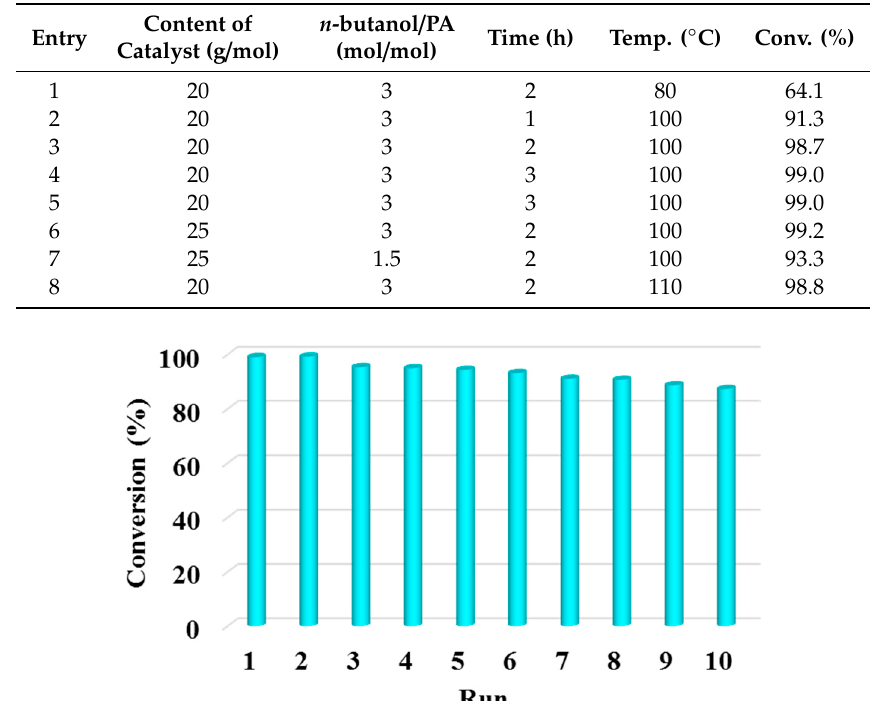
Table 4. Esterification of palmitic acid (PA) with n -butanol.